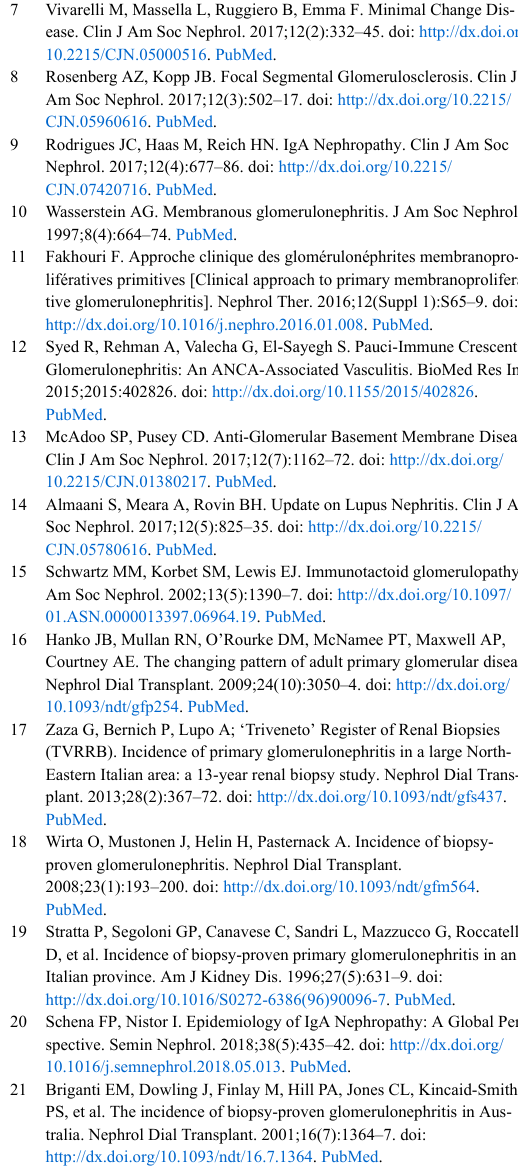
Table 4: A: The proportion (percentage) of prevalent patients with biopsy-proven glomerulonephritis between 2015 and 2018. Year Total num- Number of patients with- ber of pa- out glomerulonephritis tients with end-stage renal dis- ease on dialysis in Swiss reg- istry